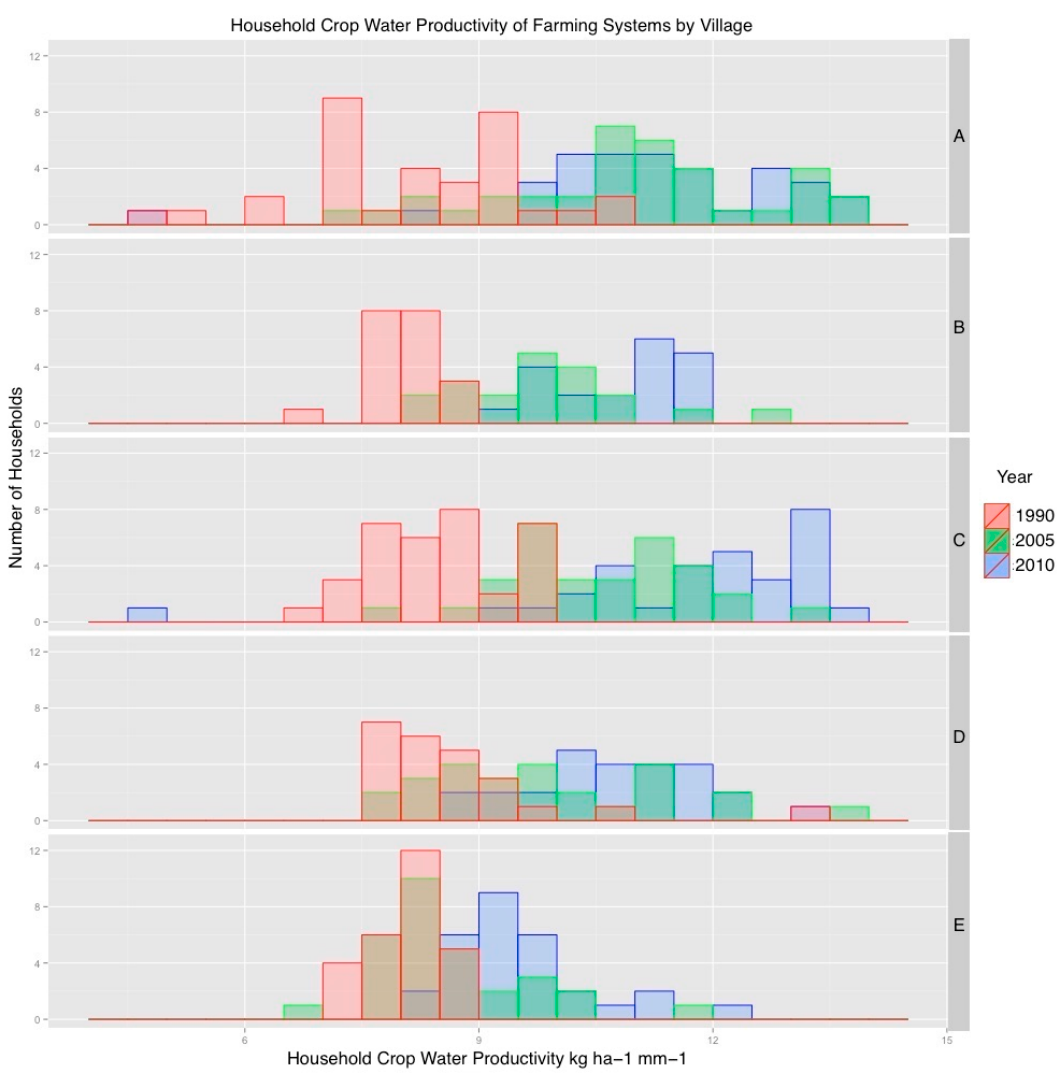
Figure 1. Household crop water productivity of farming systems by village. ( A ) Village 1; ( B ) Village 2; ( C ) Village 3; ( D ) Village 4; ( E ) Village 5. Table 4. Decomposition of change in CWP by crop and growing